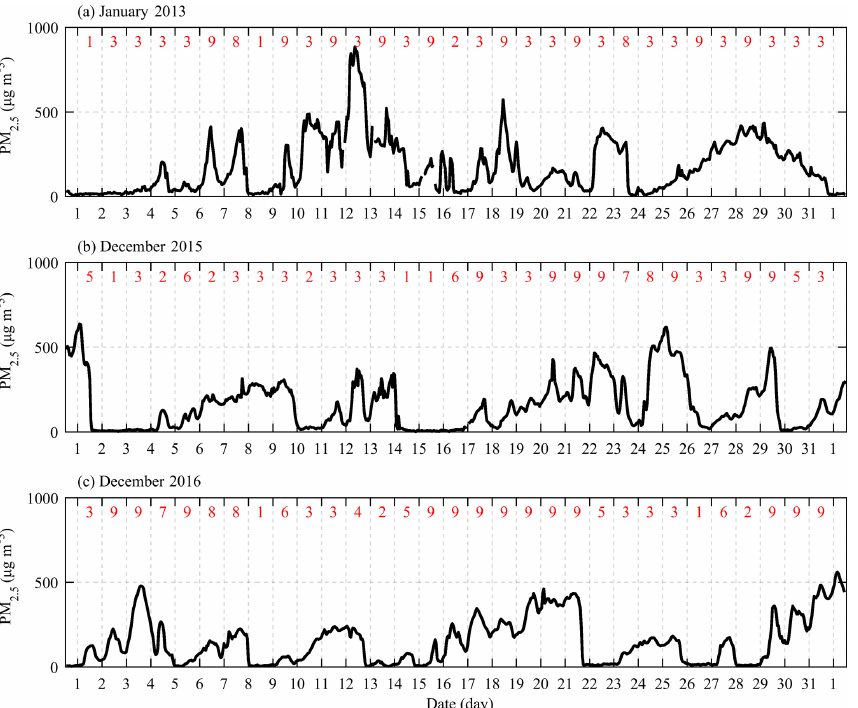
Figure 7. Time series of hourly PM 2 . 5 concentrations in (a) January 2013, (b) December 2015 and (c) December 2016. The daily ABL types (i.e., SOM nodes) are shown at the top of each plot (red